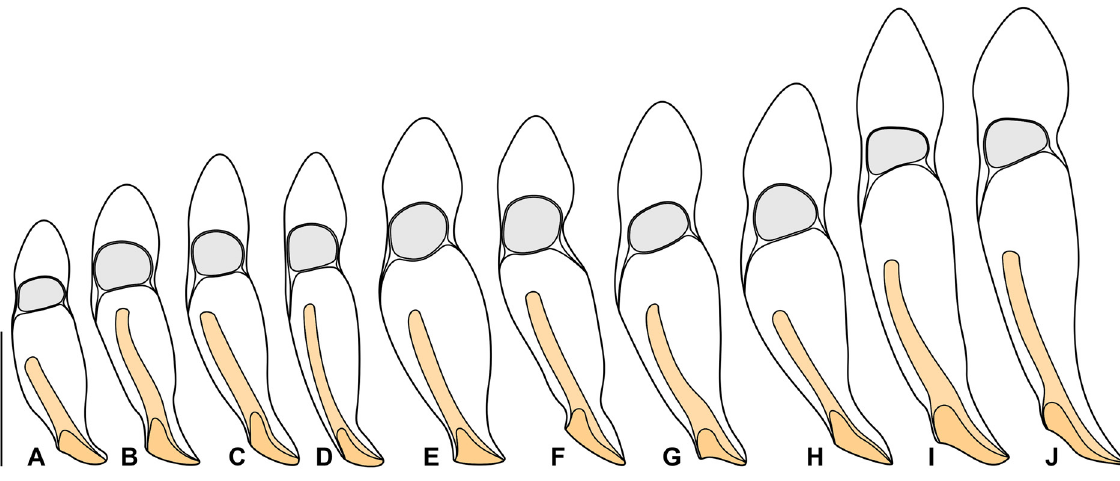
Fig. 2. Clevelandella constricta (Kidder, 1937). Thai I specimens isolated from Panesthia angustipennis angustipennis (Illiger, 1801) after protargol impregnation. A–J . Variability of body shape and size as well as of the nuclear (shaded grey) and oral (shaded yellow) apparatus. Scale bar = 50